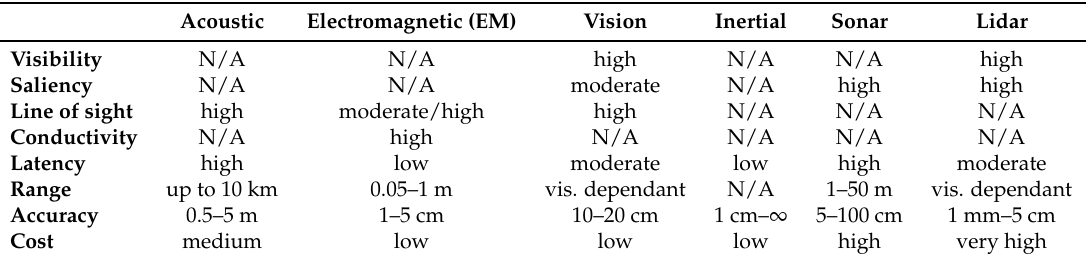
Summary of the most common underwater localization technologies against the low/moderate/high importance of possible characteristics of the environment. Also included for comparison are range, accuracy and